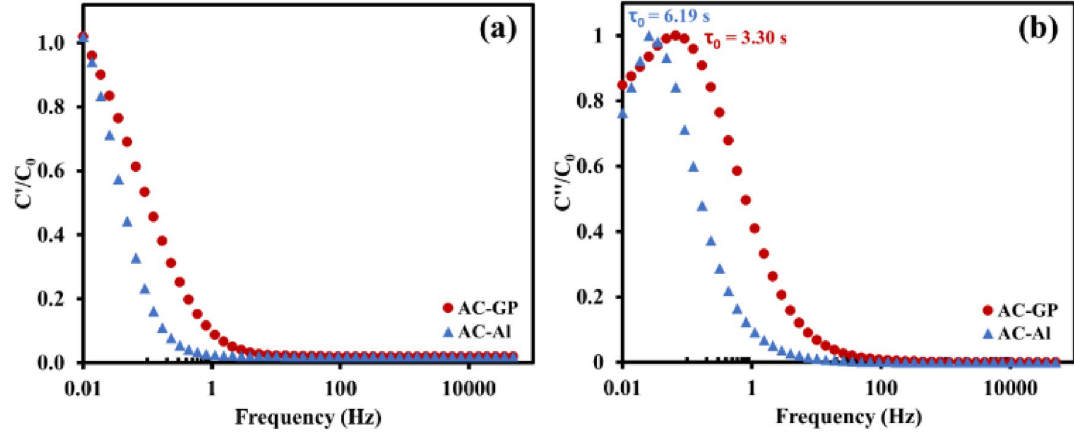
Figure 5. ( a ) real and ( b ) imaginary parts of the normalized capacitances as a function of frequencies.